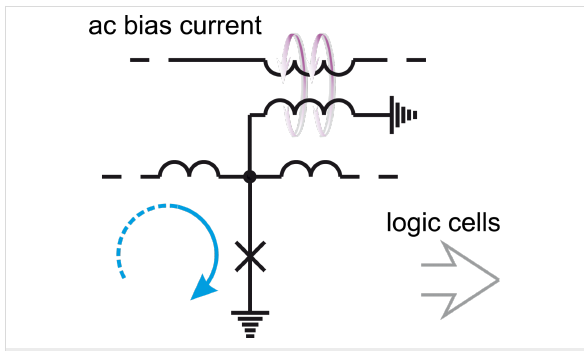
Figure 8: RQL ac power supply scheme. The blue arrow shows the SFQ current, violet arrows present magnetic